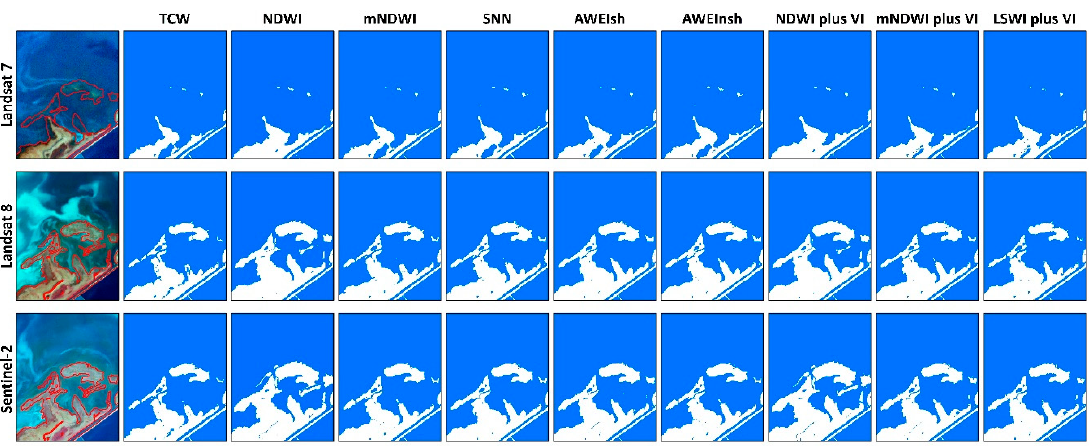
Figure 7. Contrast of the shallow water body mapping results from 27 combinations of the nine algorithms (refer to Table 2) and the three sensors (Landsat 7 ETM+, Landsat 8 OLI, and Sentinel-2 MSI).